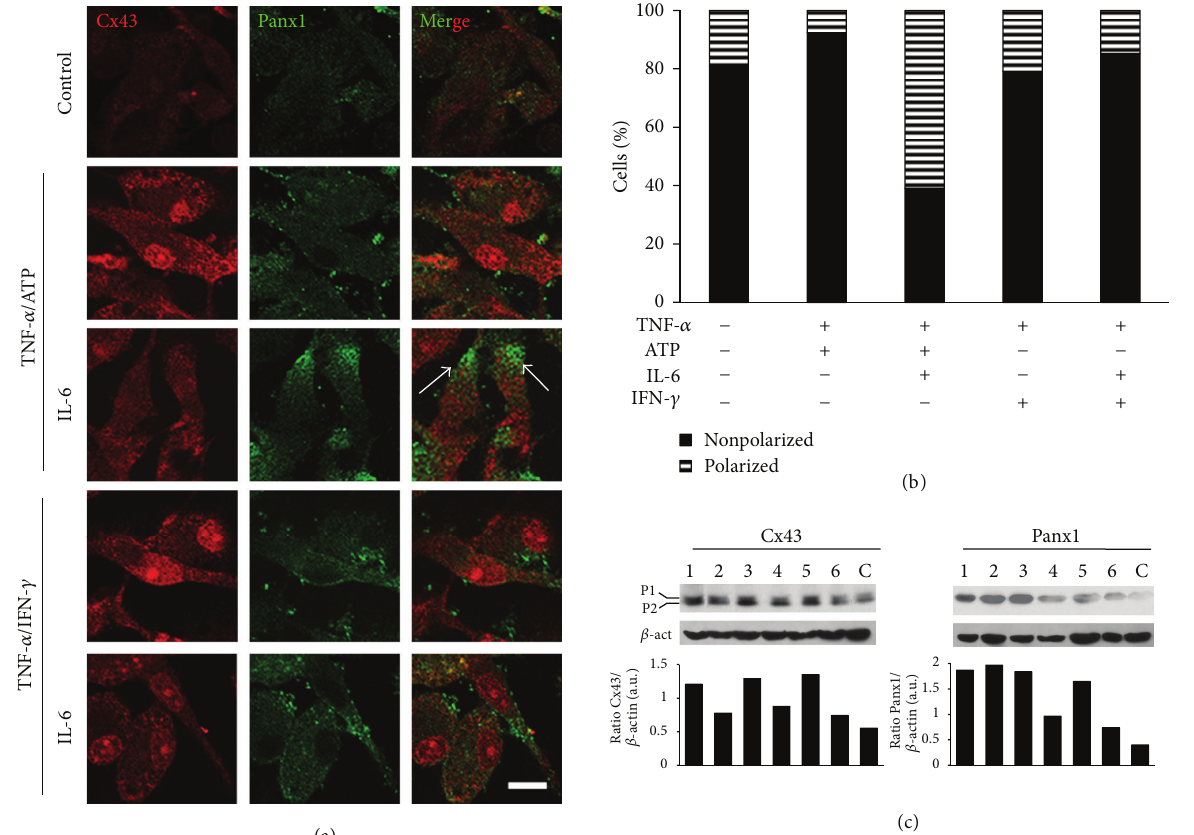
Figure 7: Pro-inflammatory treatments upregulate Cx43 and Panx1 protein levels in microglia. (a) Confocal images show immunoreactivity for Cx43 (red) and Panx1 (green) in primary rat microglia under control conditions of after treatment with TNF- 𝛼 plus ATP for 3.5 h or with TNF- 𝛼 /IFN- 𝛾 for 9h, in absence or presence of IL-6 (10 or 50ng/mL, respectively). Arrows show microglia with segregation of Cx43 and Panx1. Scale bar: 10 𝜇 m. (b) Quantification of nonpolarized (black bars) versus polarized (dashed white bars) rat microglia under control conditions or after treatments shown in (a). Data are expressed as a percentage of the total number of cells per field, 𝑛 = 5 (up to 100 cells per field). ∗ 𝑃 < 0.05 versus control condition. (c) Representative Western blots from 3 independent experiments showing total protein levels of Cx43 and Panx1. Cell lysates were obtained from EOC20 cells under control conditions (lane C) or after the following treatments: TNF- 𝛼 plus ATP (lane 1), IL-6/TNF- 𝛼 plus ATP (lane 2), TNF- 𝛼 /IFN- 𝛾 (lane 3), IL-6/TNF- 𝛼 /IFN- 𝛾 (lane 4), TNF- 𝛼 /IL-1 𝛽 (lane 5), and IL-6/TNF- 𝛼 /IL-1 𝛽 (lane 6). Quantitation of Cx43 and Panx1 is shown; 𝛽 -actin was used as a loading control for densitometric